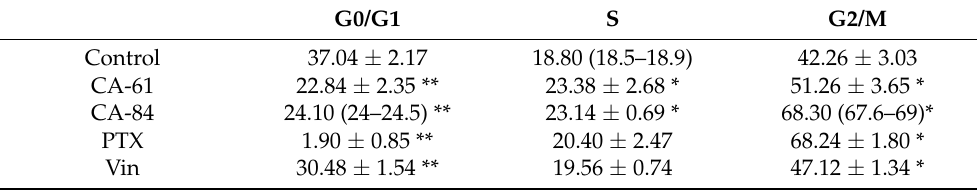
Table 3. Quantitative analysis of the cell-cycle distribution in HCC1806 breast cancer cells as mea- sured by the flow cytometry described in Figure 7. Normally, distributed data are presented as mean ± standard deviation, non-normally distributed data are shown as median (interquartile range); * p < 0.05, ** p <